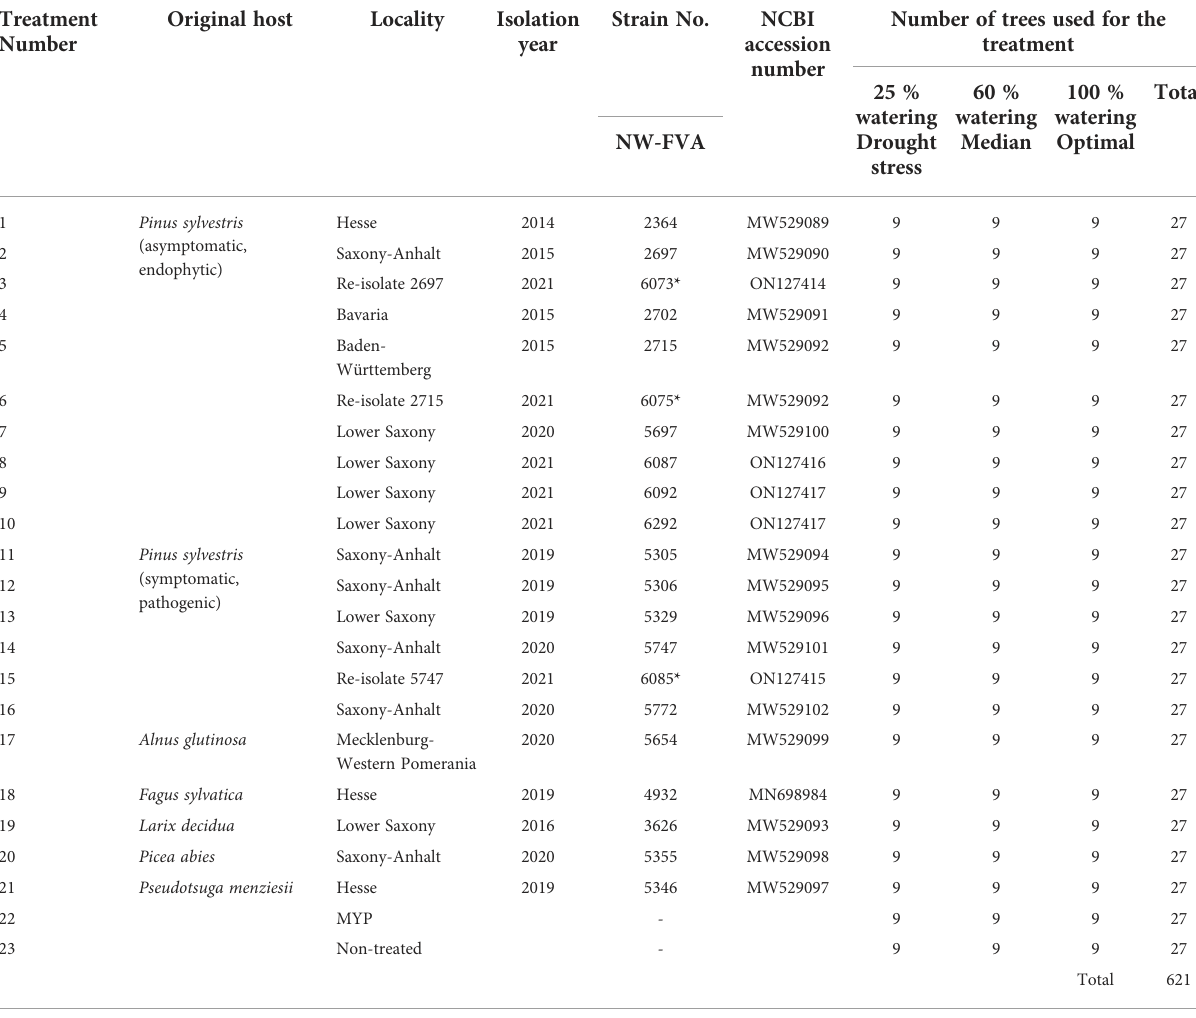
TABLE 1 List of Diplodia sapinea strains used in inoculations of the Scots pines, watering regimes and number of replicates (trees). Treatment